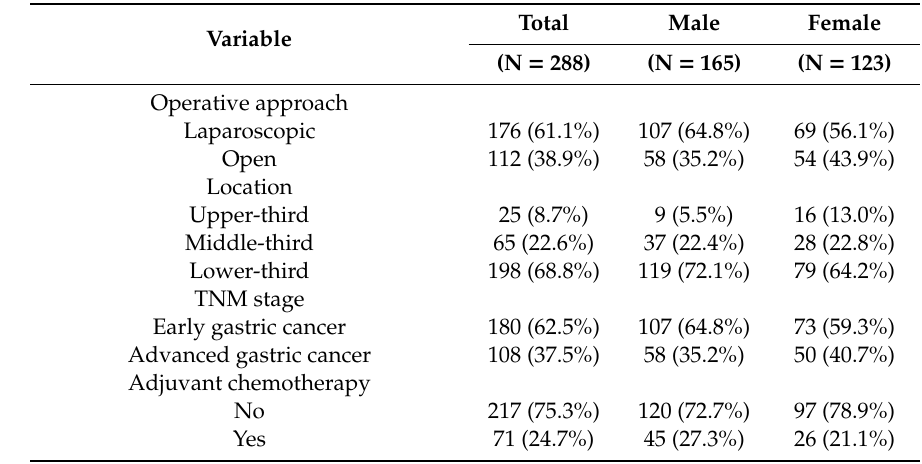
Estimated Marginal Mean * (95%